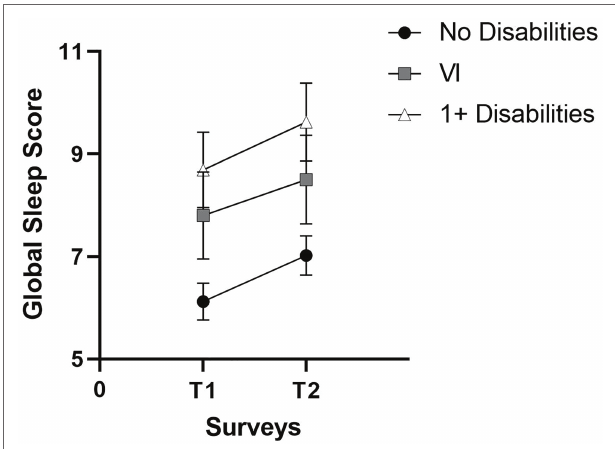
FIGURE 1 | Pittsburgh Sleep Quality Index global sleep mean scores at T1 and T2.